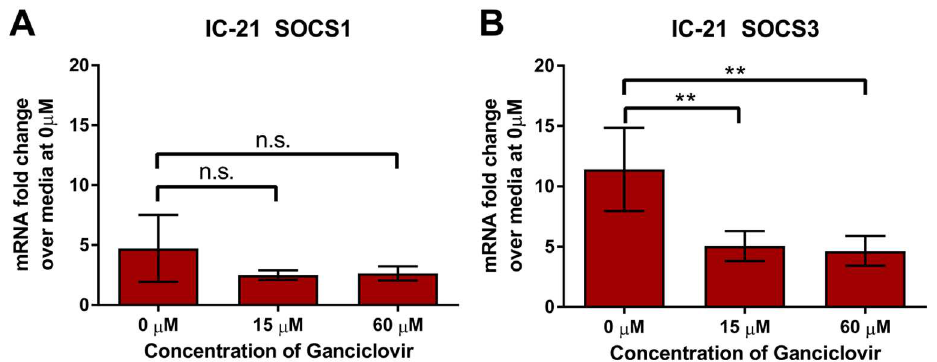
Fig 9. Ganciclovir (GCV) treatment of MCMV-infected mouse macrophages reduces MCMV-related stimulation of SOCS3 mRNA at 72 hpi. IC-21 mouse macrophages were treated with media (baseline control) or infected with SG-MCMV (MOI = 3 PFU/cell). At 1 hpi, wells were treated with the antiviral drug GCV at the indicatedfinal concentrations, or vehicle control (0 μ M). At 72 hpi, cells were harvestedand assessed for SOCS1 (A) or SOCS3 (B) mRNA by real-time RT-PCR assay using the comparative 2 - ΔΔ Ct method, with all samples comparedback to the vehicle-treated (0 μ M) media group. Means ± SD of at least triplicate experimental repeats are shown. * p < 0.05, ** p < 0.01,and n.s.: not significant,for MCMV-infected GCV- treated groupscomparedwith MCMV-infected